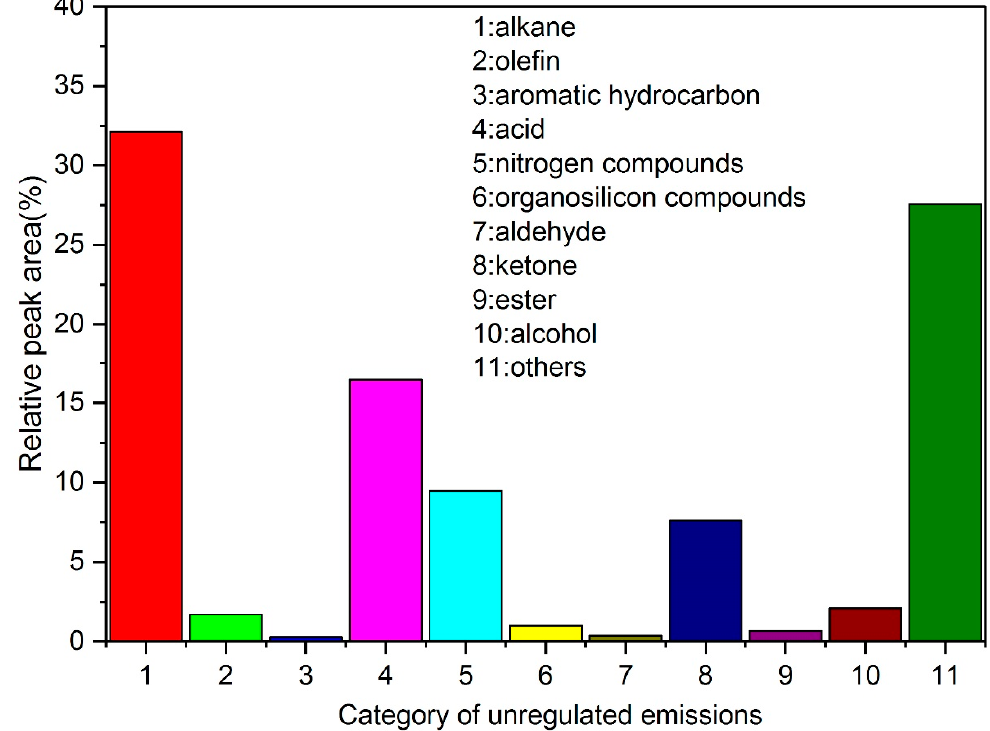
Figure 7. Relative concentration of unregulated emissions absorbed by activated carbon in conventional diesel combustion.